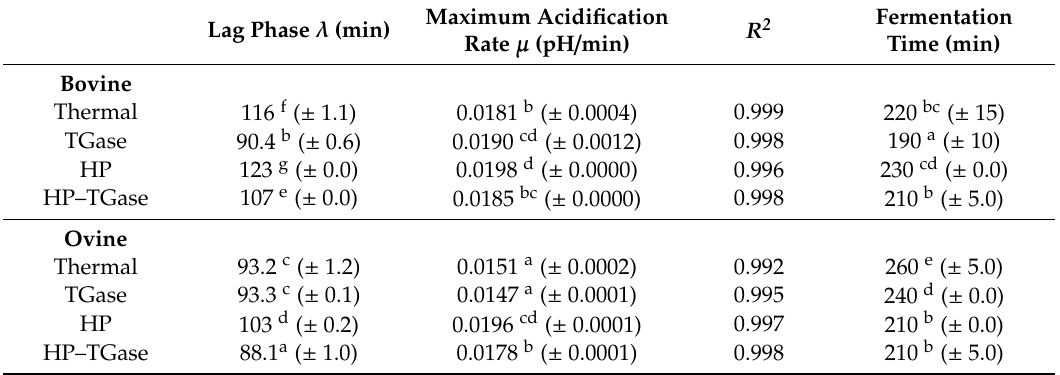
Table 2. Fermentation kinetics parameters and fermentation times of bovine and ovine milk